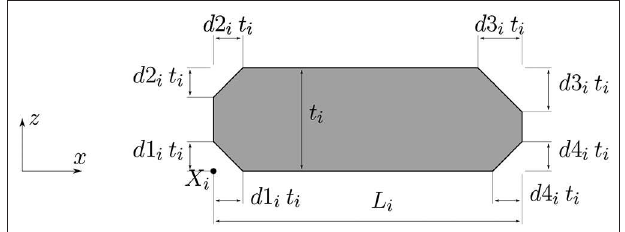
FIGURE 7 | Parameterization of a chamfered